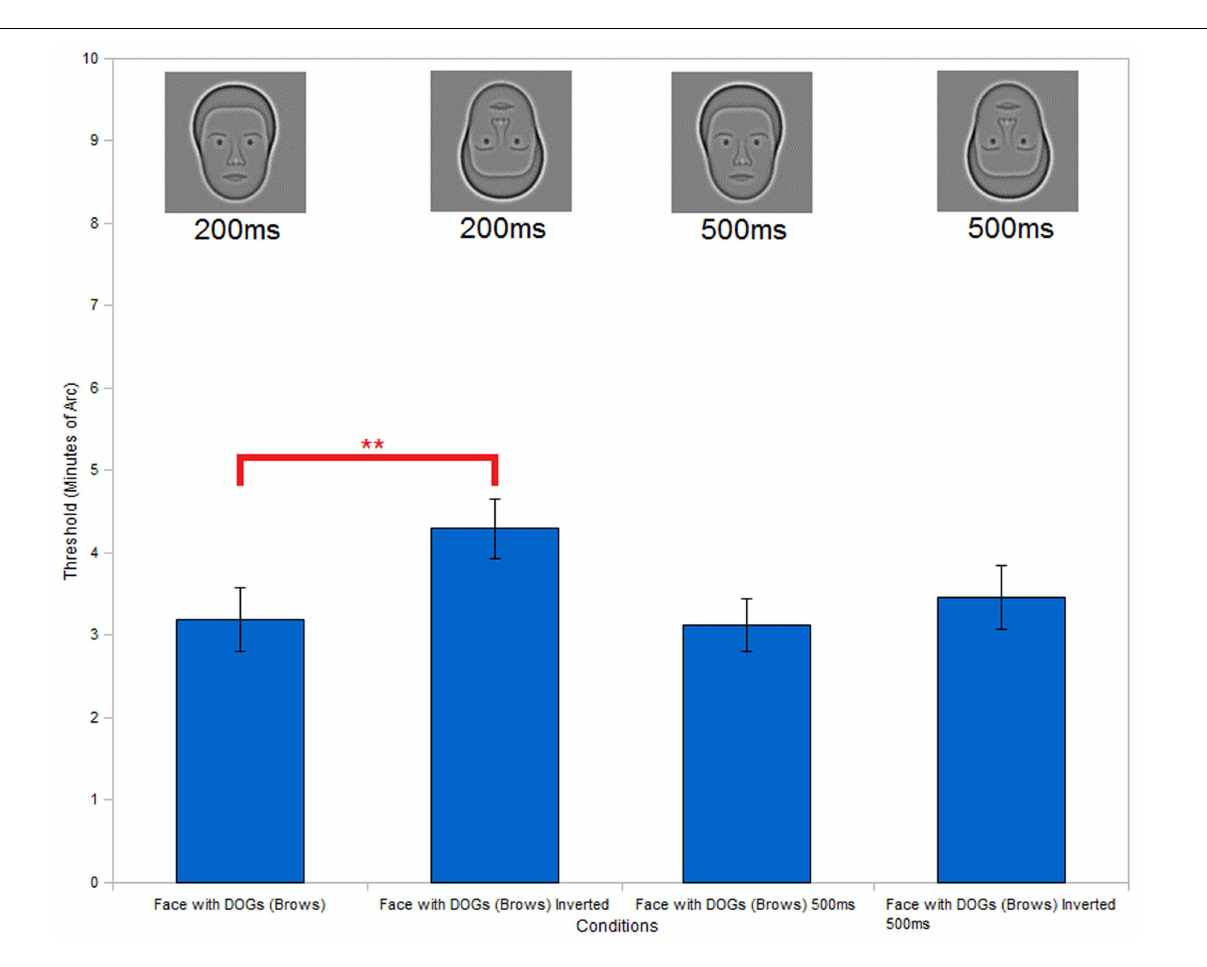
FIGURE 8 | Full face with eyebrows inversion. Inversion test of the face with DOGs condition (with added eyebrows) shows a significant improvement in performance of the upright condition versus the inverted condition at an